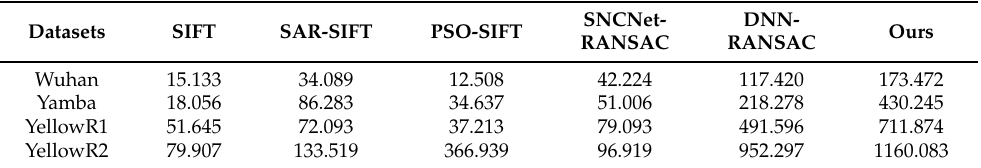
Table 6. Running times of our method and five compared methods on the four data.